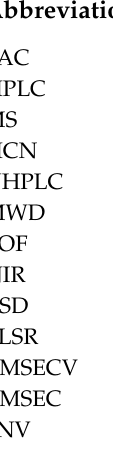
plot of NIR data with UHPLC-MWD-UHR-TOF-MS reference method. Figure S6. The loadings of the PLSR model correlating NIR spectra of sambucus fructus with pH-di ff erential reference values for TAC content. Figure S7. The loadings of the PLSR model correlating NIR spectra of sambucus fructus with UHPLC-MWD-UHR-TOF-MS reference values for TAC content. Figure S8. Cumulative explained variance plot of the PLSR model correlating NIR spectraofsambucusfructuswithpH-di ff erentialreferencevaluesforTACcontent. FigureS9. Cumulativeexplained variance plot of the PLSR model correlating NIR spectra of sambucus fructus with UHPLC-MWD-UHR-TOF-MS reference values for TAC content. Figure S10. NIR spectrum of cyanidin-3-O-sambubioside simulated with use of quantum chemical calculations. Individual contributing overtone and combination bands are presented. Figure S11. NIR spectrum of cyanidin-3-O-sambubioside-5-O-glucoside simulated with use of quantum chemical calculations. Summed contribution from either overtone or combination bands are presented. Figure S12. Workflow of the